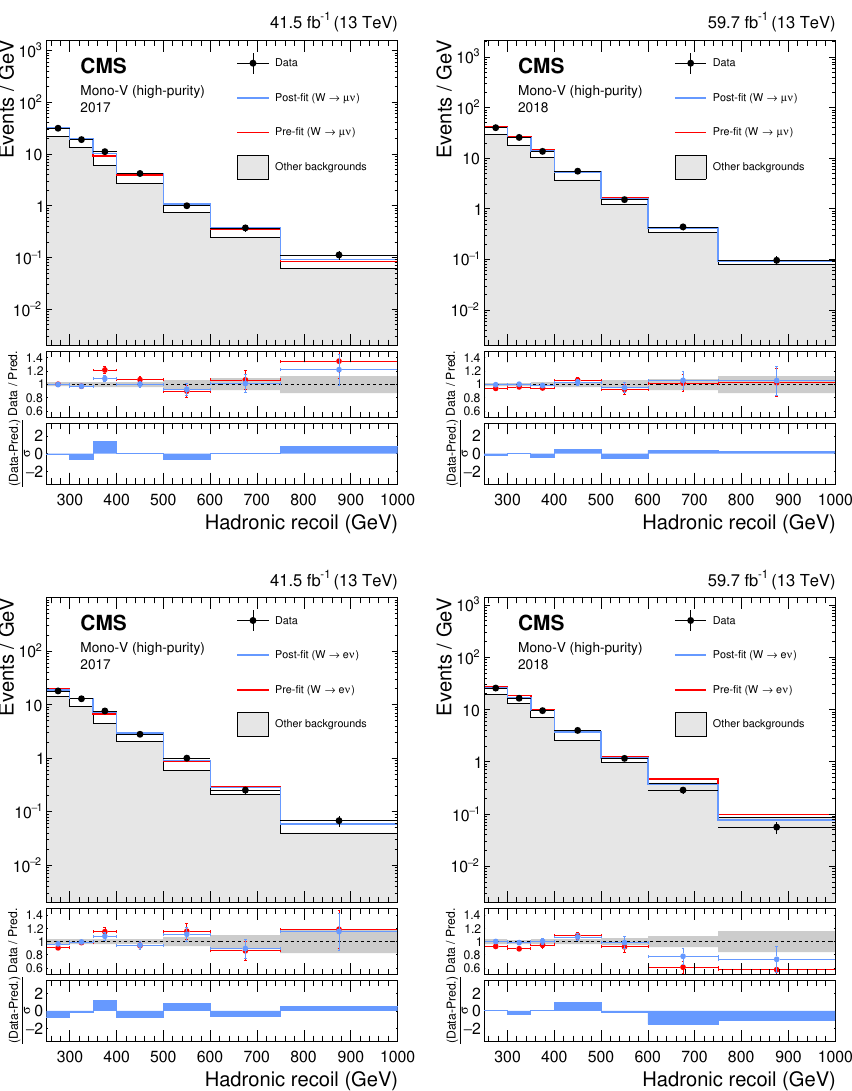
Figure 18 . Hadronic recoil distributions in the single muon (upper), and single electron regions (lower) in the high-purity mono-V category. The “Other backgrounds” include top quark, diboson, and QCD multijet